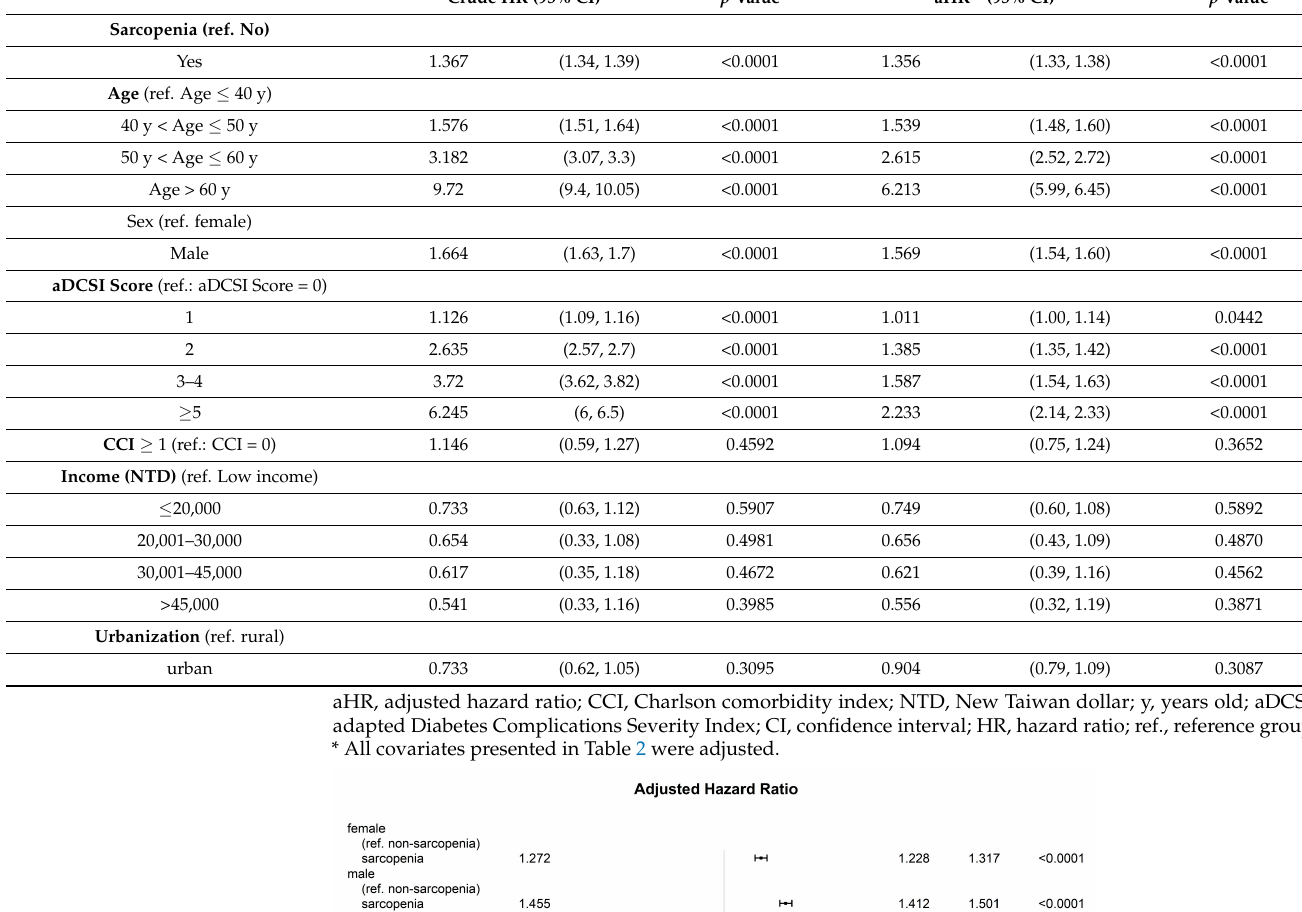
aHRs (95% CIs) for the sarcopenia diabetes group were significantly associated with higher mortality compared with the control group, regardless of age group, sex, or aDCSI scores. Table 2. Univariable and multivariable Cox proportional regression results for all-cause death of the propensity score-matched patients with diabetes. Crude HR (95% CI) p Value